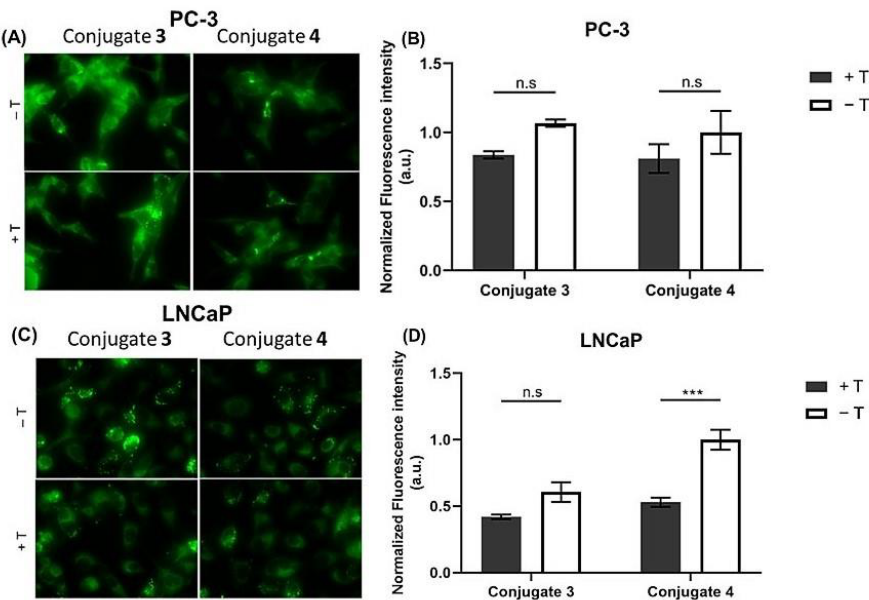
Figure 5. Internalization of 19-nortestosterone-BODIPY conjugates 3 and 4 in PC-3 and LNCaP prostate cancer cells with or without testosterone (T). PC-3 and LNCaP cells were incubated for 1 h with a specific inhibitor (+T) or without an inhibitor ( − T). After 6 h of incubation, ( A ) PC-3 and ( B ) LNCaP cells were visualized using an inverted microscope with magnification 400 × , and the fluorescence intensity was quantified for each cell line, ( C , D ), respectively. The fluorescence intensity of the cells was corrected for background fluorescence and normalized with vehicle (DMSO). The statistical significance was evaluated by the two-way ANOVA method (*** p ≤ 0.001 , n.s — not significant).